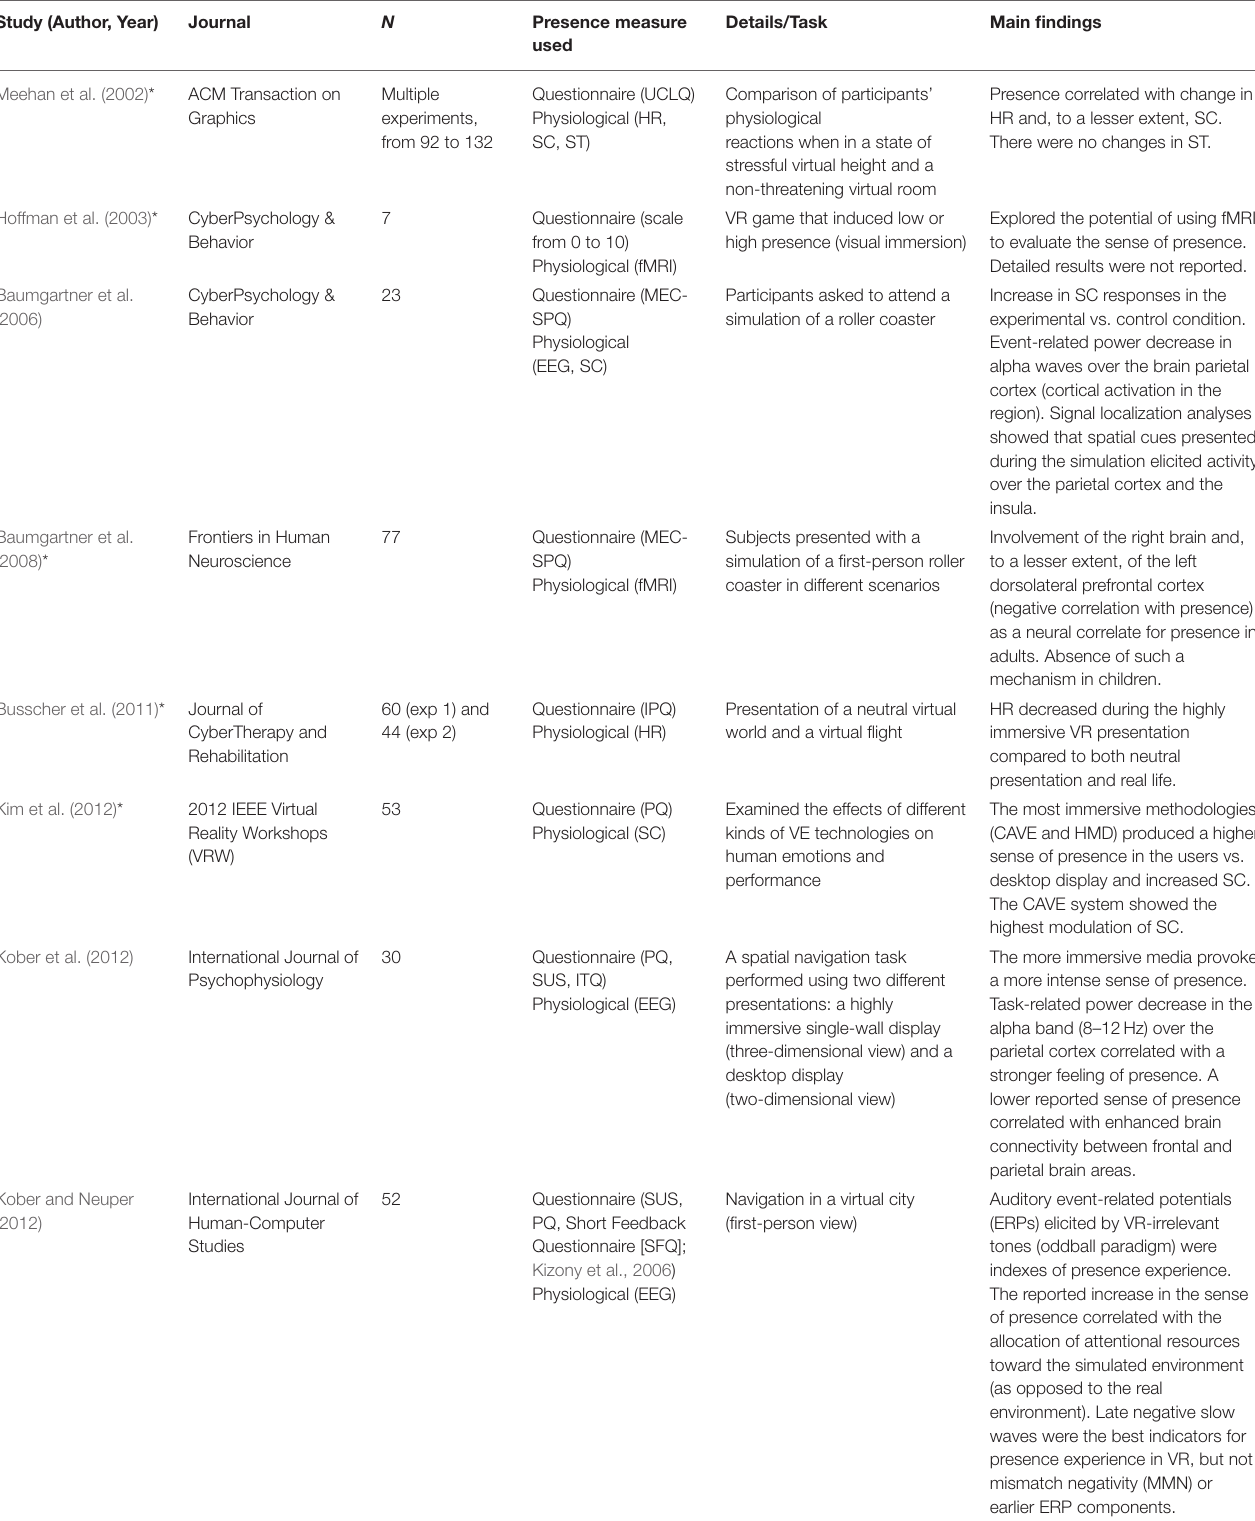
TABLE 1 | Summary of reviewed articles, listed from the oldest to the newest (and alphabetically for publications from the same